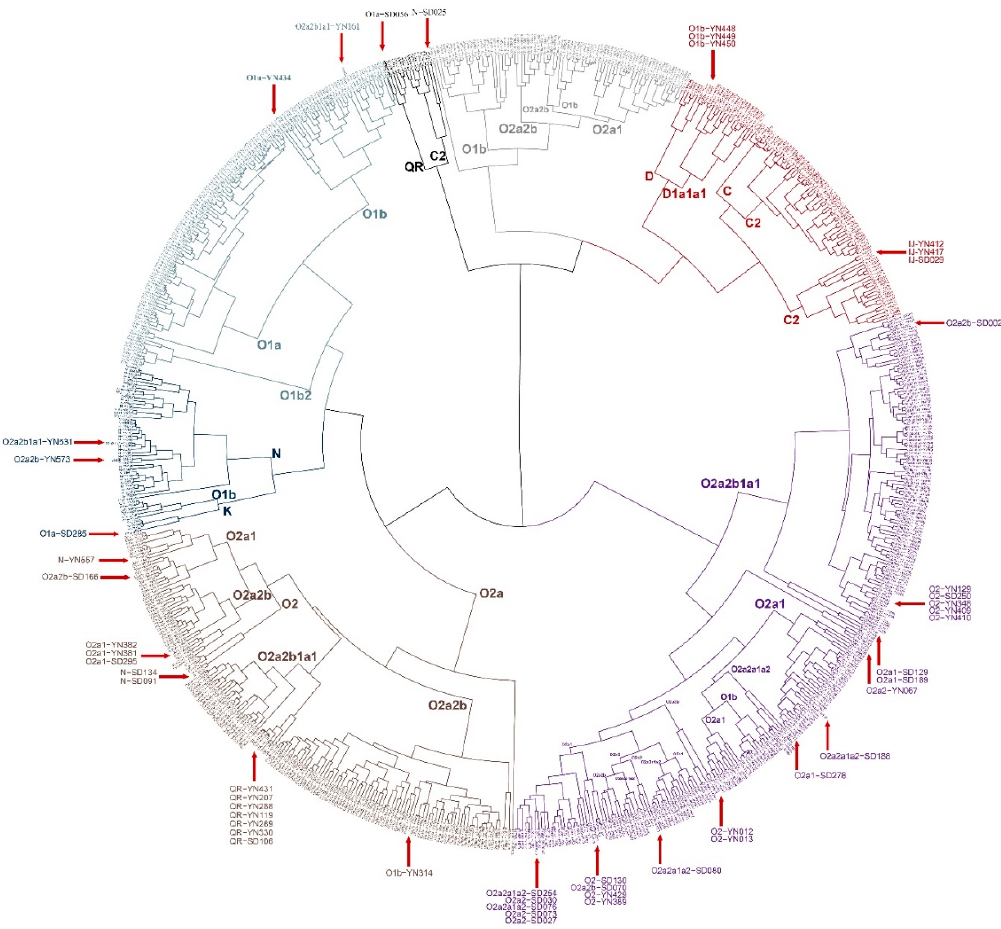
Figure 7. Phylogeny tree based on the 27-Y-STR panel. All samples are marked with the measured Y haplogroup, where “YN” and “SD” are abbreviations for Yunnan and Shandong, respectively. Different colors refer to various clusters. Red arrows denote those near-match Y-STR haplotypes which were classified into other different or proximate Y-SNP clades.